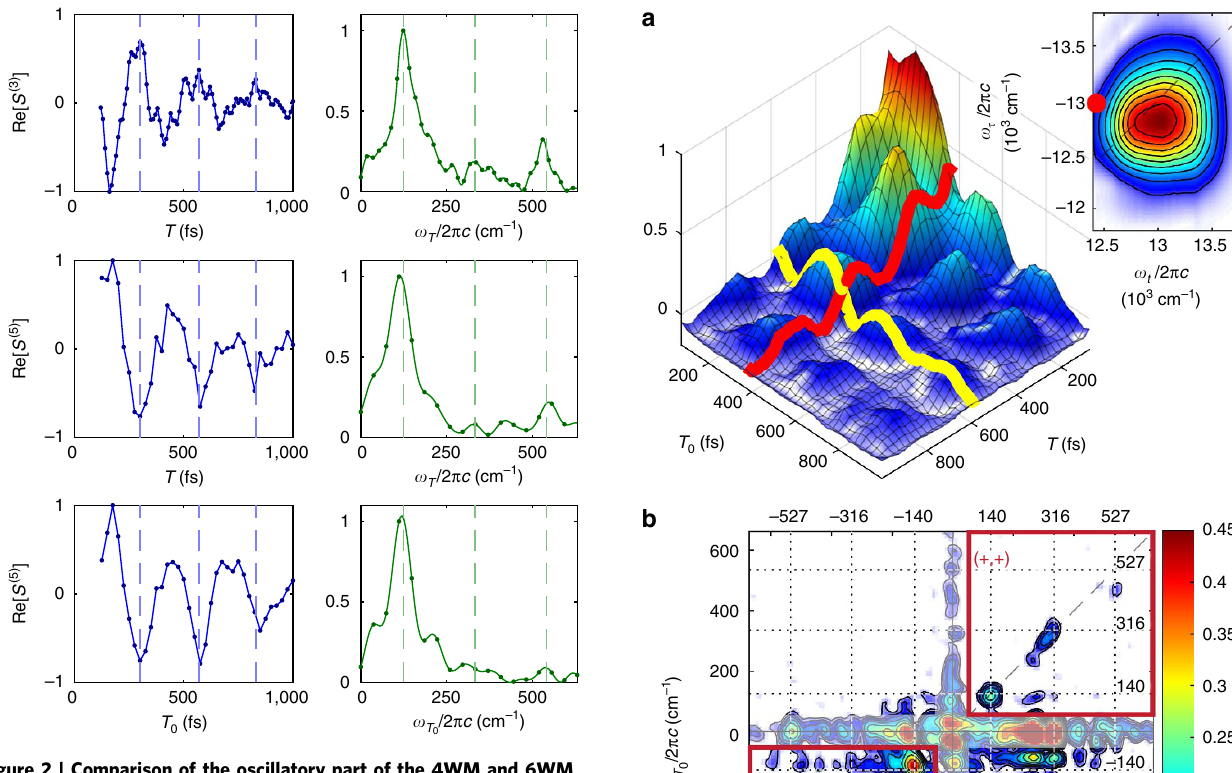
Figure 2 | Comparison of the oscillatory part of the 4WM and 6WM signals in IR-140. The top row of panels show the real part of the four-wave mixing (4WM) signal as a function of T (left panel) and its Fourier transform (right panel). The middle and bottom rows of panels show the real part of the six-wave mixing (6WM) signal as a function of T at T 0 ¼ 100fs and as a function of T 0 at T ¼ 100fs, respectively, along with their Fourier transforms. All transients were taken from the blue side (along o t ) of the main peak in the 6WM 2DFT electronic spectrum. Blue dashed lines mark peaks (troughs) in the 4WM (6WM) transients. Green dashed lines mark the 125, 330 and 540cm (cid:4) 1 oscillation frequencies.